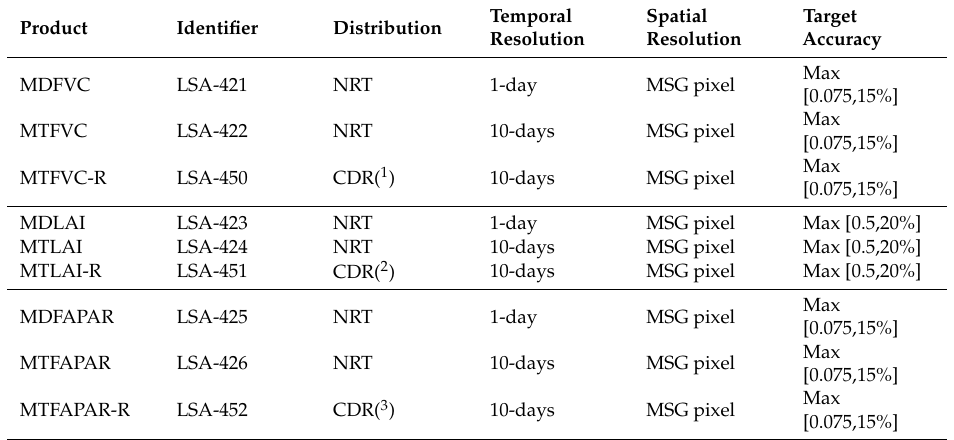
Table 1. Product Requirements for MSG vegetation products, in terms resolution and